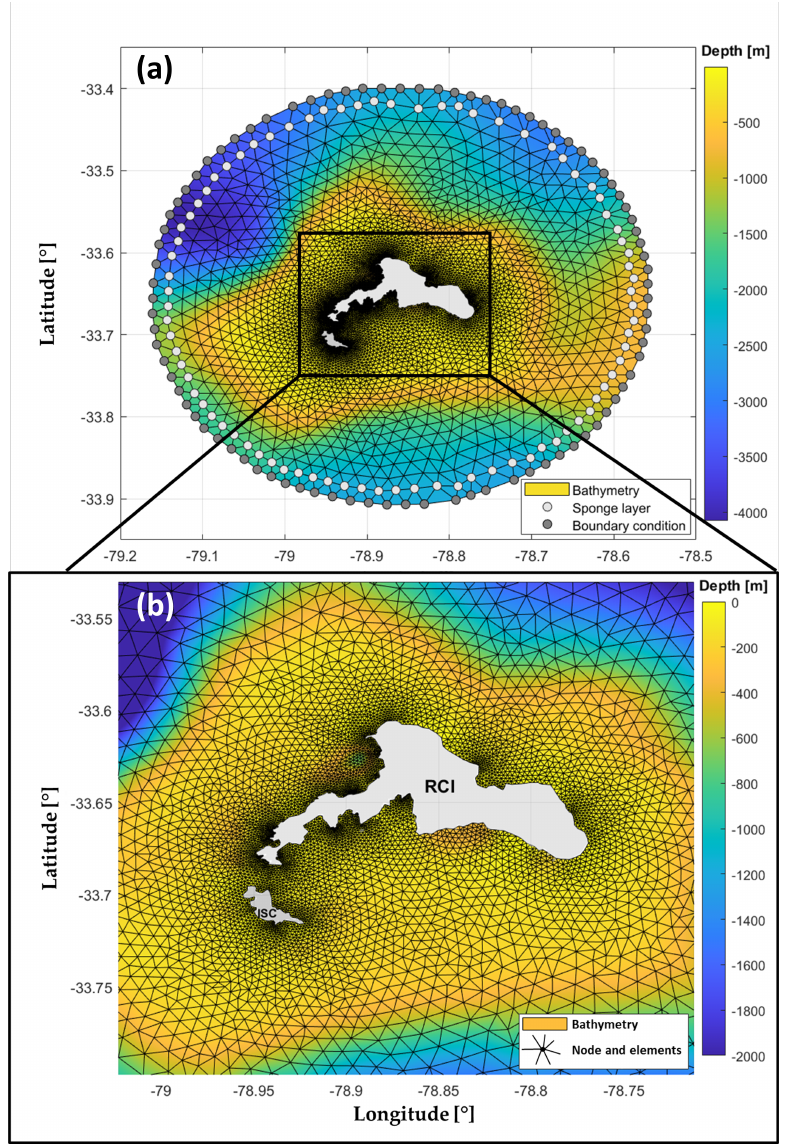
Figure 3. Unstructured triangular grid used for FVCOM modeling. ( a ) Model domain. Boundary and sponge nodes are indicated as dark and light-gray circles, respectively. ( b ) Zoom-in to the Juan Fernández Archipelago region. RCI: Robinson Crusoe